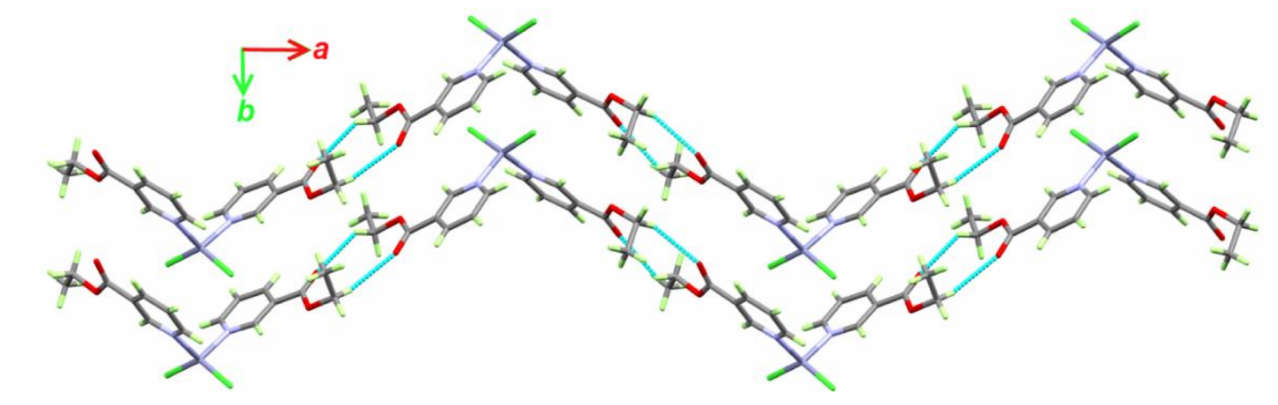
Figure 3. Wave-like packing of 1 along the a b